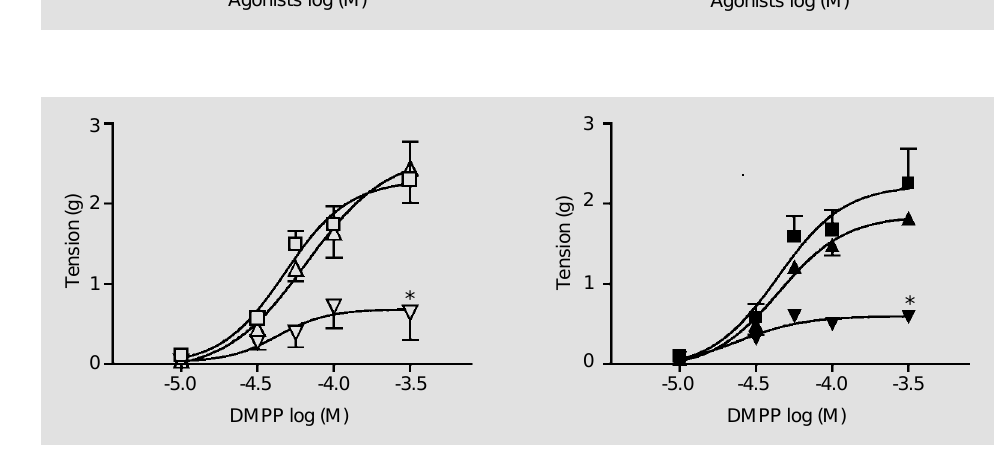
Figure 1 - Noncumulative con- centration-effect curves (60-min interval) for dimethylphenylpi- perazinium (DMPP) (squares, N = 6), cytisine (inverted triangles, N = 12), nicotine (circles, N = 18) and carbachol (triangles, N = 6) in the prostatic portion of the rat vas deferens. Animals were killed at 15:00 h (open symbols) or 21:00 h (closed symbols). Data are reported as mean ± SEM.